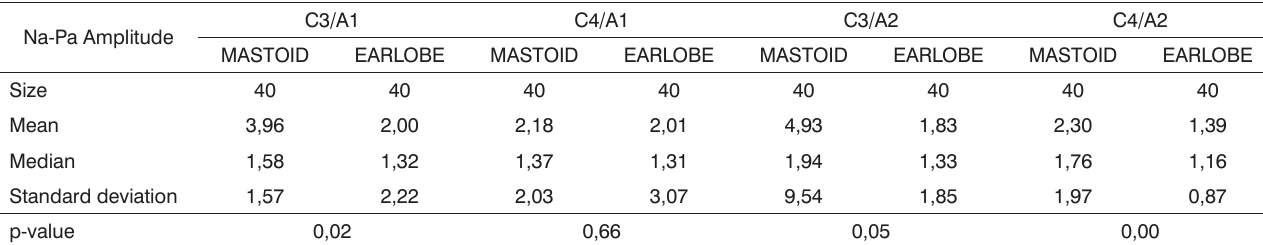
Table 1. Comparing Na-Pa amplitudes in MLEAP C3/A1, C4/A1, C3/A2, C4/A2 modes between mastoid and earlobe